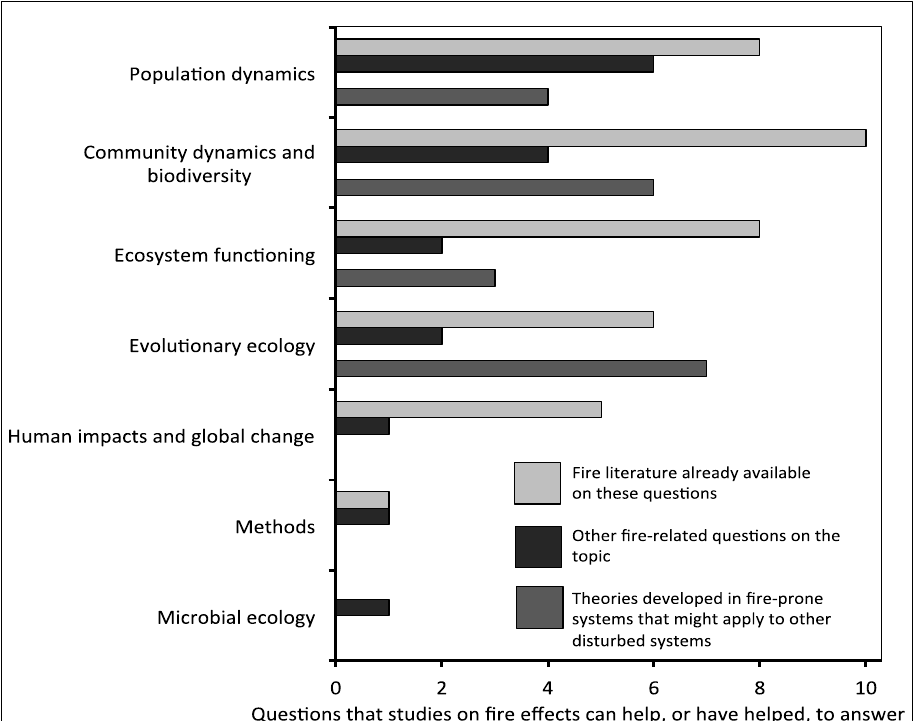
Figure 2. Collation of 55 ‘fundamental’ ecological questions of the 100 compiled by Sutherland et al. (2013) that we show can be addressed in the context of fire effects (Table A3). Our survey shows that a number of these (two- thirds) have already received some attention in the fire literature (light grey bars) and that a more thorough literature survey might show that some research has been undertaken on the remainder (black bars). No question has been examined exhaustively and fireprone systems are ideal settings for addressing many of them. In addition, we identified 20 theories/models derived from fire-related research (Table 2) and collated them here with the same headings as used for the ecological questions for comparative purposes (dark grey